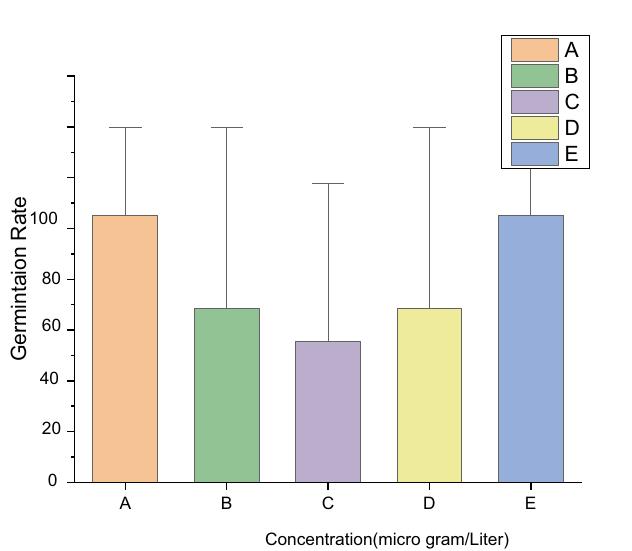
Figure 9. ( a ) Sclerotinias sclerotiorums , ( b ) Rosellinia necatrixs , ( c ) Fusariums strains.